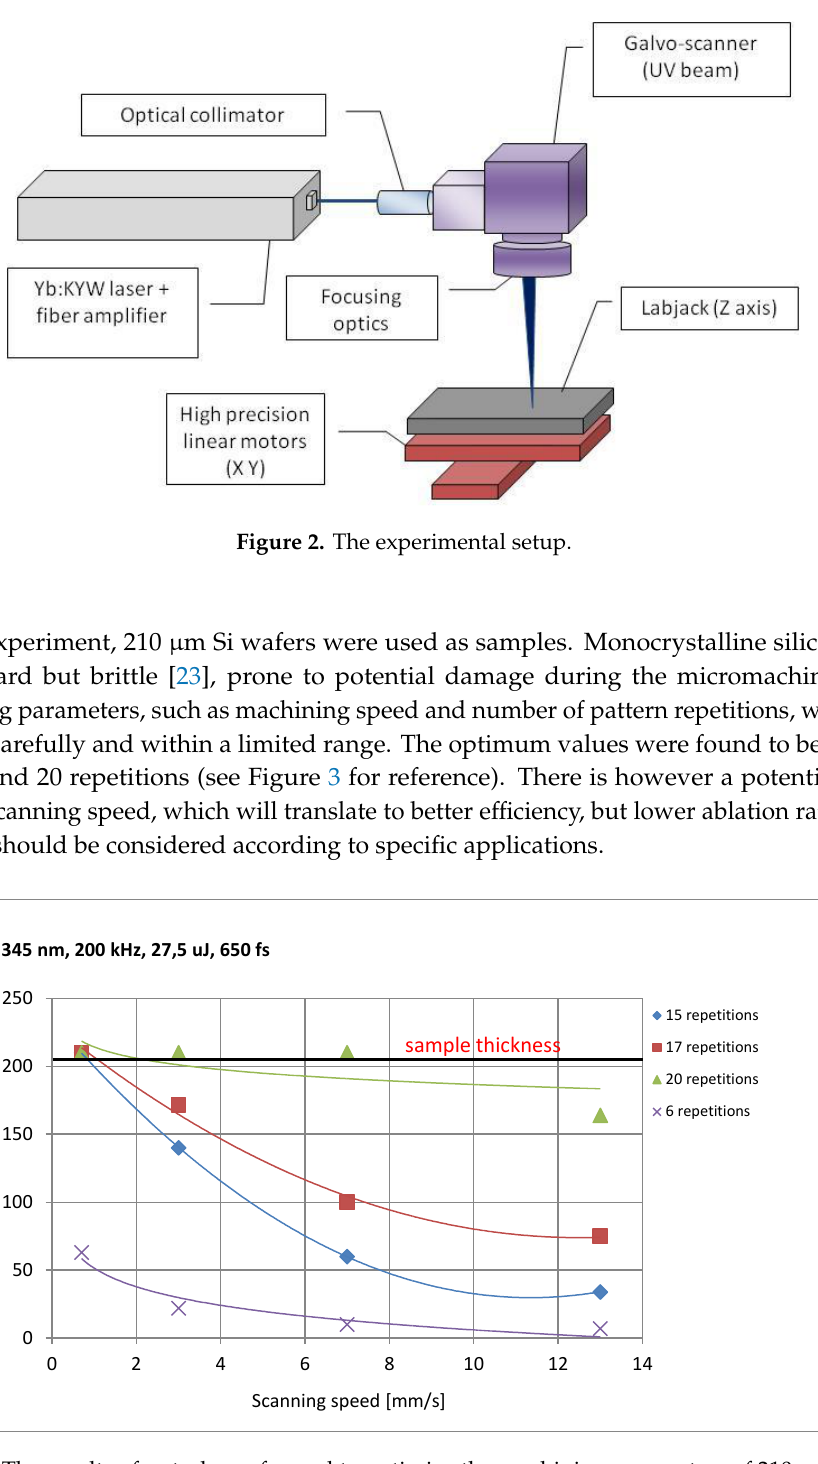
Figure 3. The results of a study performed to optimize the machining parameters of 210 µm silicon wafers. The samples were scribed with 4 different values of scanning speed (0.7–13 mm/s), in 4 variants of pattern repetitions (6–15x). The ablation depth of the craters was then measured for each case. Laser beam parameters: 650 fs, 343 nm, 200 kHz, 27.5 µJ.